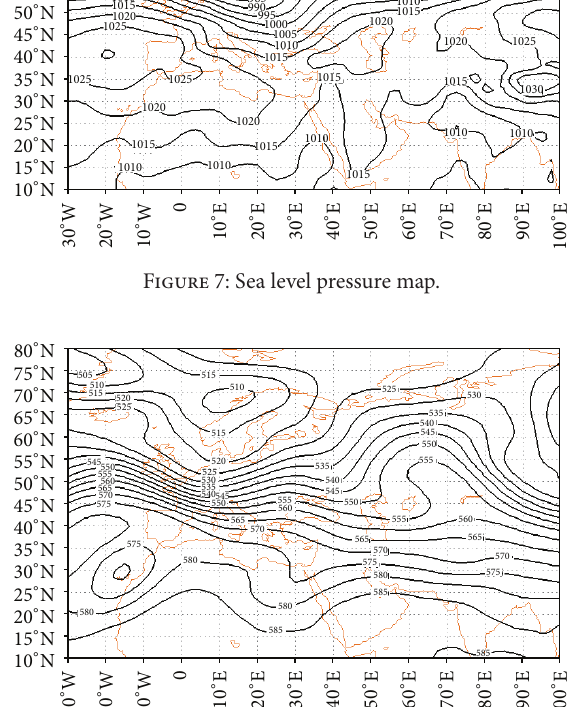
degrees east longitude and 55 degrees north latitude) with a closed contour of 1030 HPa is formed, and due to the slow progress of this system in 500 HPa level, atmosphere currents are divided into two directions with the high pressure current extending to Iran and the study area (Figure 11). This pattern in 500 HPa level displays a trough located in the east of the study area and directs the descent of cold weather from upper latitudes over the region, extending at the sea level of